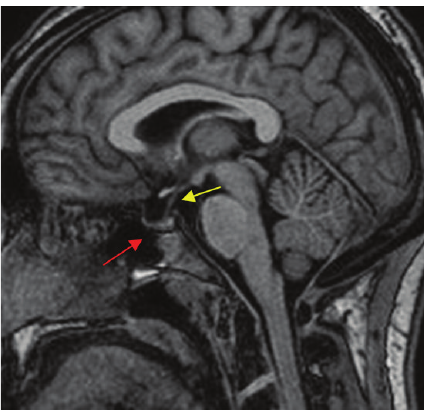
Figure 4: Postoperative sagittal T1 MRI of brain without contrast shows resolution of the prior areas of hyperintensity within the sella turcica (red arrow). The pituitary stalk is now visible (yellow